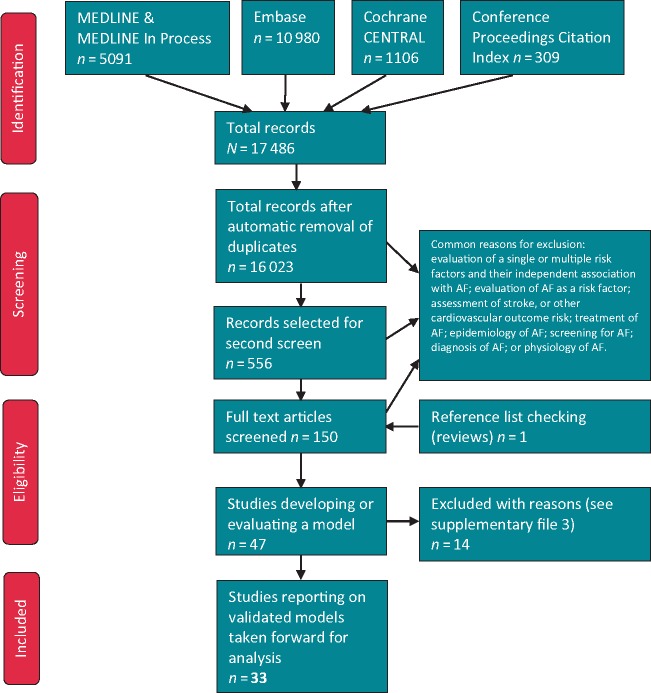
PRISMA flow diagram. AF, atrial fibrillation.